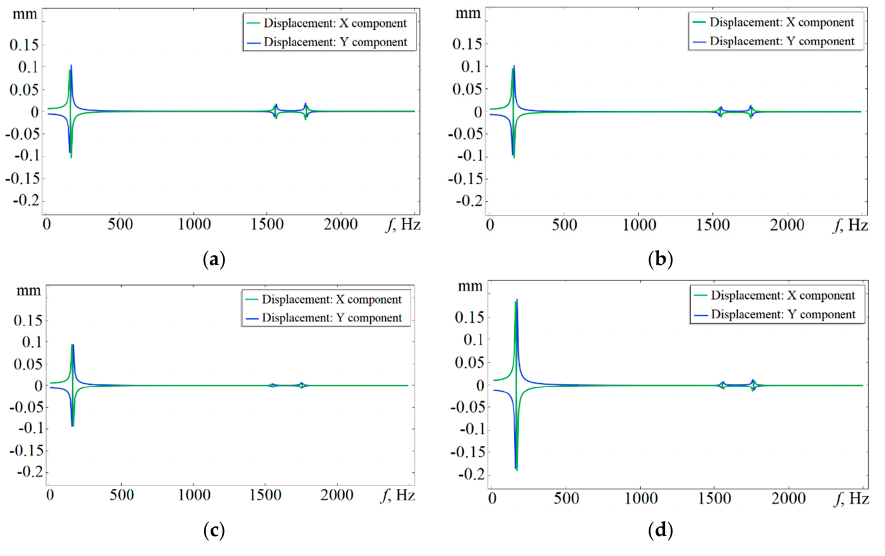
Figure 9. Frequency responses of displacement of the stator of the investigated motor with supply voltage imbalance: ( a ) I A = I B = I C ; ( b ) I A = 1.1 · I B = 0.9 · I C ; ( c ) I A = 1.4 · I B = 0.8 · I C ; ( d ) I g 3 = 15.4 A, I g 5 = 7.7 A, I A = 1.4 · I B = 0.8 · I C .